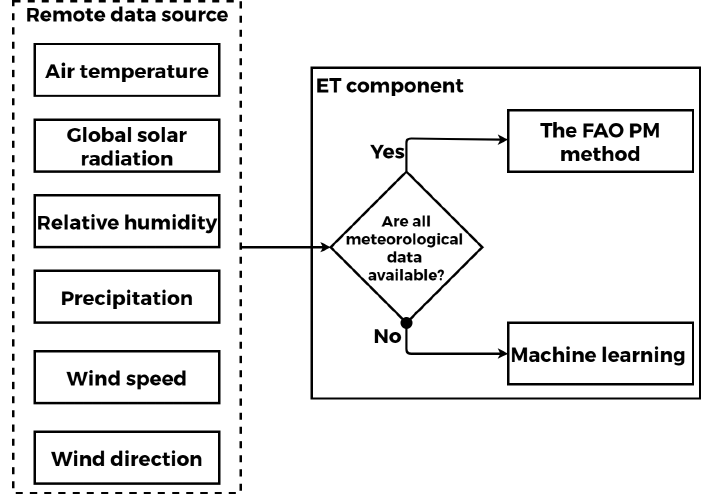
Figure 11. The logic of the Evapotranspiration estimation component.